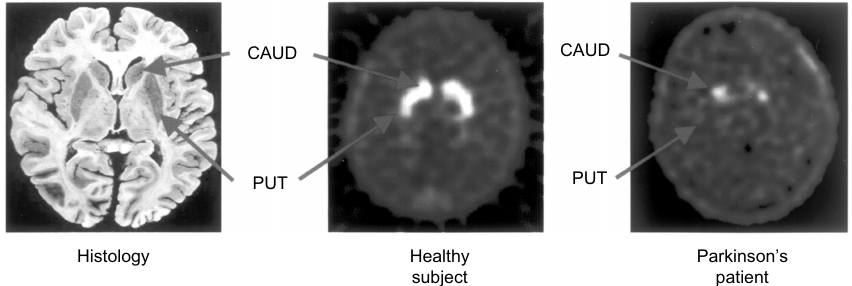
Fig. 2. Transverse SPECT images of [ 99m Tc]TRODAT-1 binding to dopamine transporters in human subjects [114]. Left: histology slice through the brain at the level of the striatum to show the head of the caudate nucleus (CAUD) and the putamen (PUT). Centre: transverse SPECT image at the same level from a healthy subject, showing high concentrations of [ 99m Tc]TRODAT-1 binding to dopamine transporters in the caudate and putamen. Right: SPECT image at the same level in a patient with bilateral Parkinson’s disease, showing significant reductions of